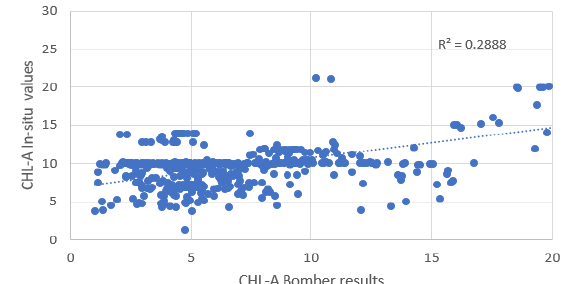
Figure 11. Comparison of in situ chl-a (µg/l) with estimates from BOMBER using default parameter values.